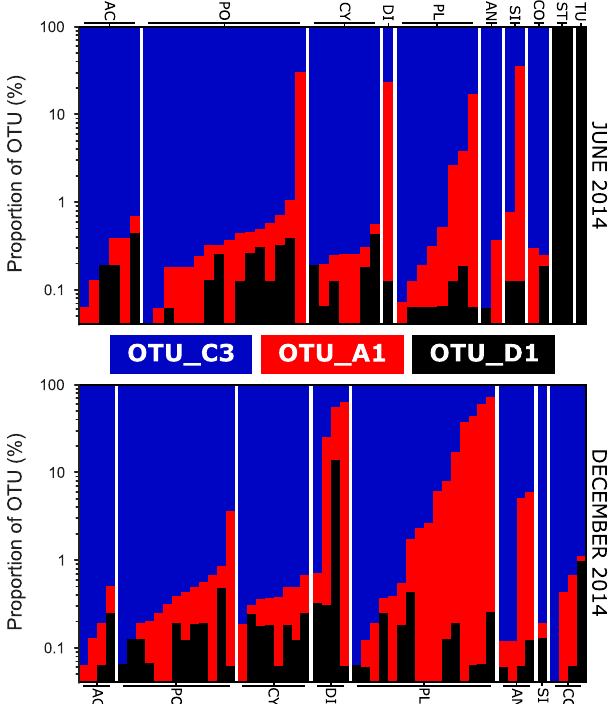
Figure 4. Distribution of ITS2 OTUs within and between Umm Al Quwain lagoon corals sampled in June (upper panel) and December (lower panel) 2014. Each bar represents an individual colony, and these are grouped by genus. Note: vertical axes are log scaled. Labels above and below plots indicate the relevant genera (AC = Acropora , PO = Porites , CY = Cyphastrea , DI = Dipsastrea , PL = Platygyra , AN = Anomastrea , SI = Siderastrea , CO = Coscinaraea , ST = Stylophora , TU = Turbinaria